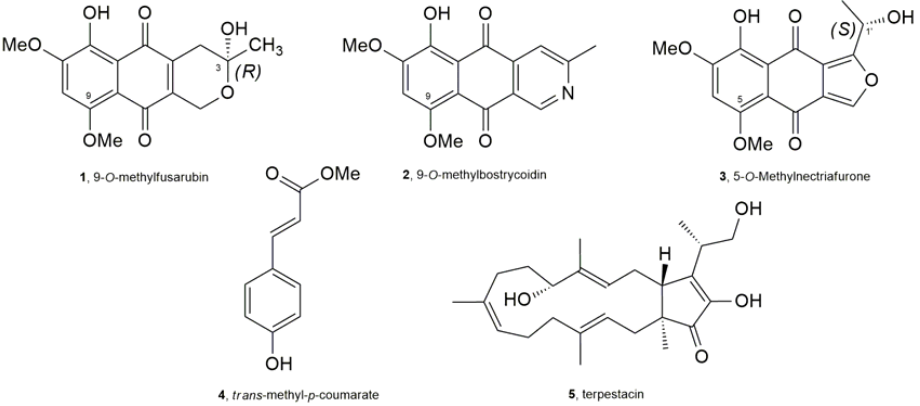
Figure 2. Structures of compounds 1 – 5 .